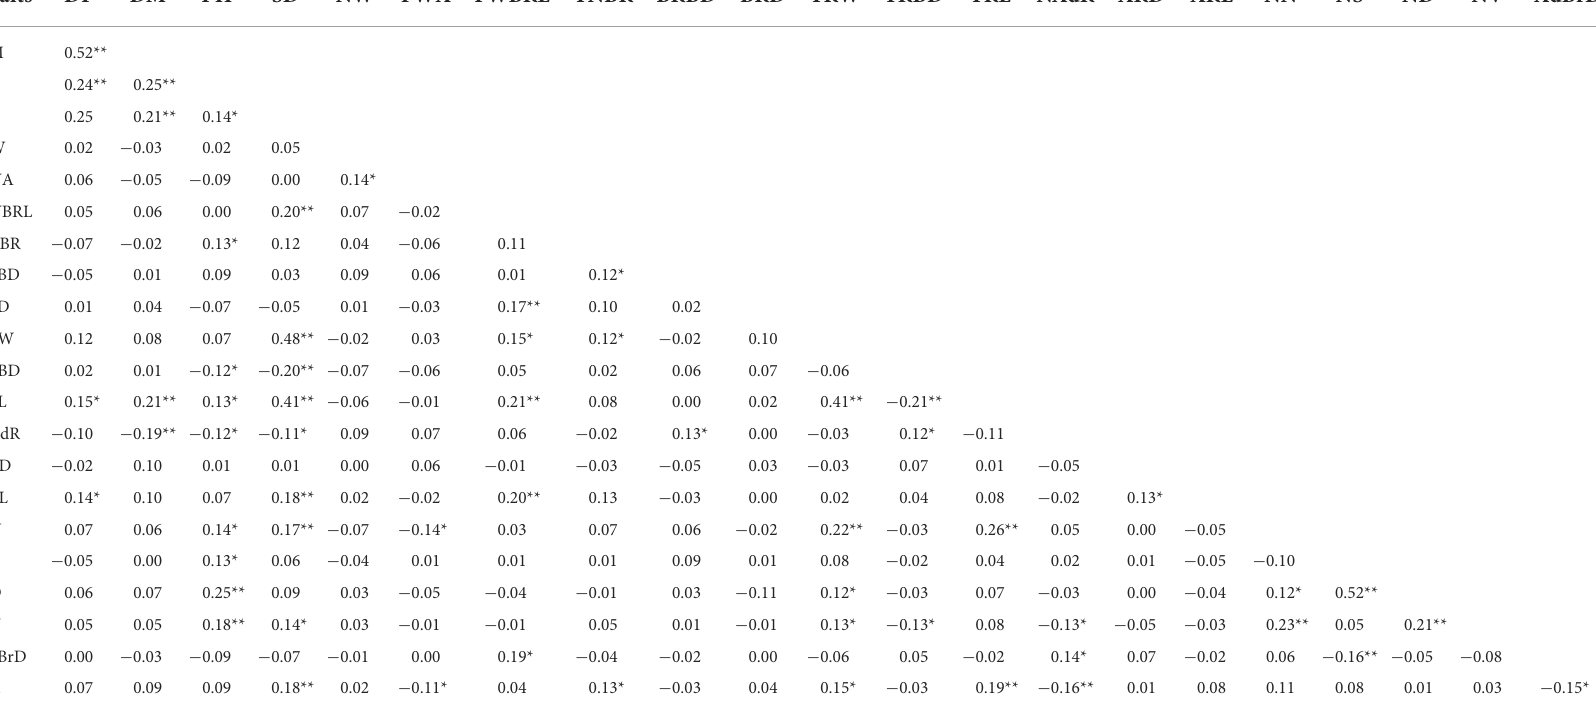
TABLE 2 Phenotypic correlation among cowpea grain yield and root phenotype traits.